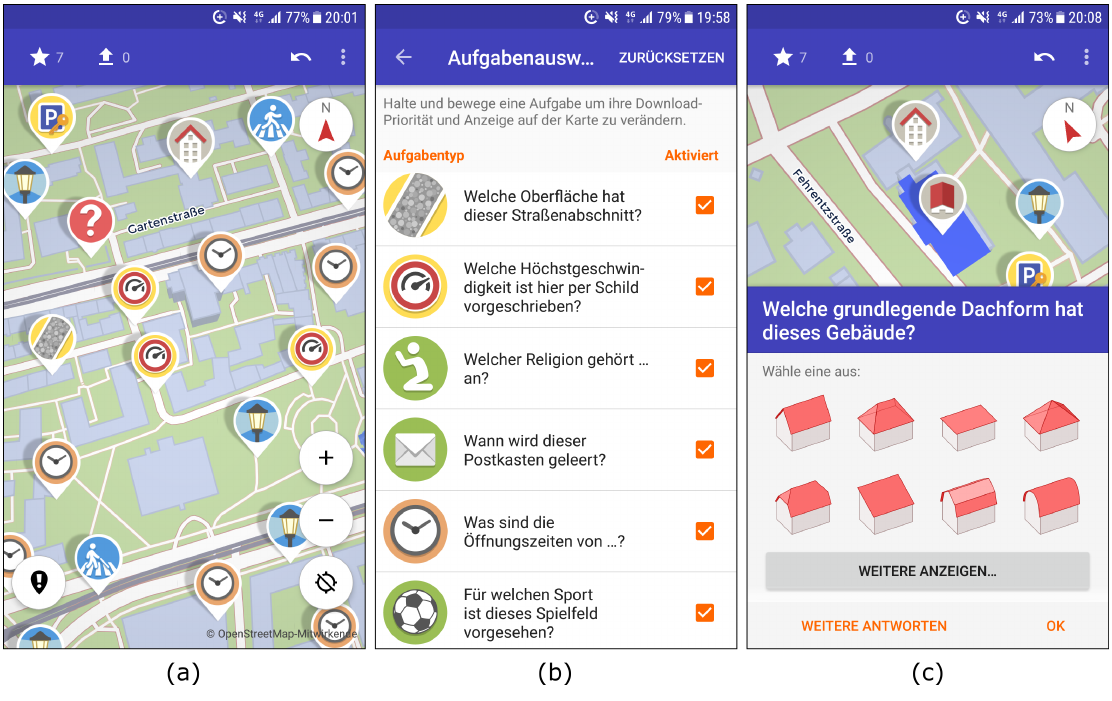
Figure 1. The StreetComplete interface. ( a ) The map-based overview; ( b ) the menu for selecting preferred task categories; ( c ) an example of visual aid supporting the answering of